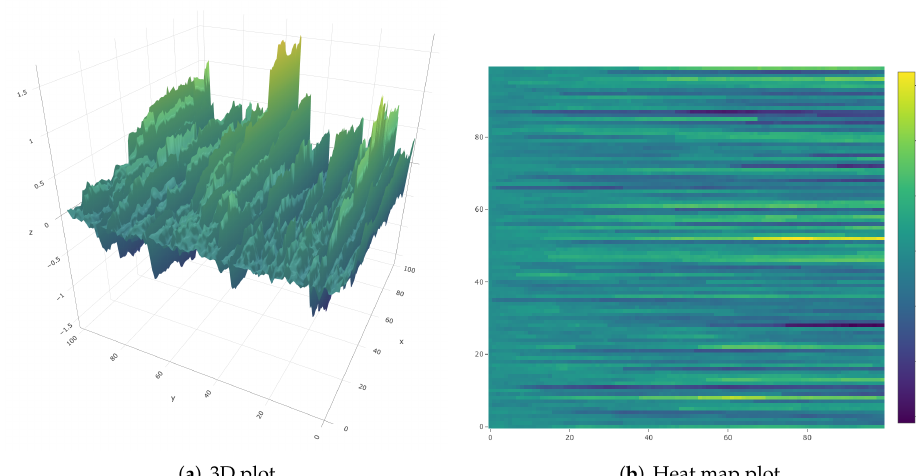
Figure 7. Functional data set ( Y j ) .